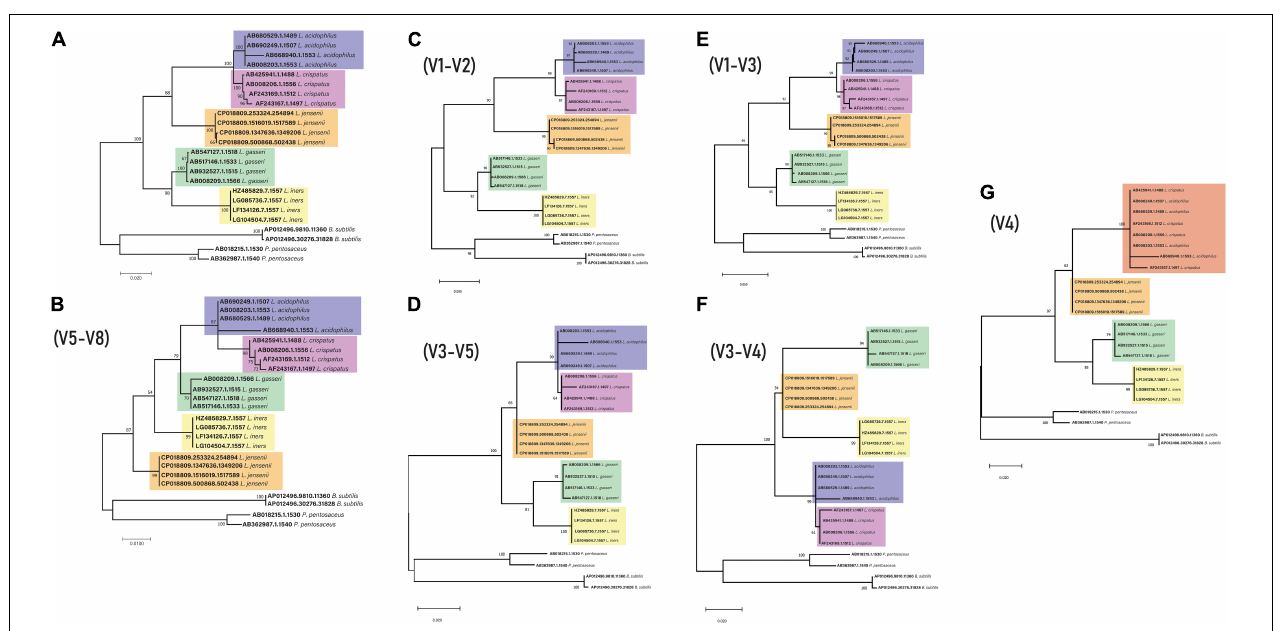
FIGURE 2 | 16S rRNA gene phylogeny for key genital tract lactobacilli (A) Full length (B) V5-V8 region (C) V1–V2 region (D) V3–V5 region (E) V1–V3 region (F) V3–V4 region (G) V4 – The different color for the top clade is due to the mixed L. acidophilus and L. crispatus sequences.